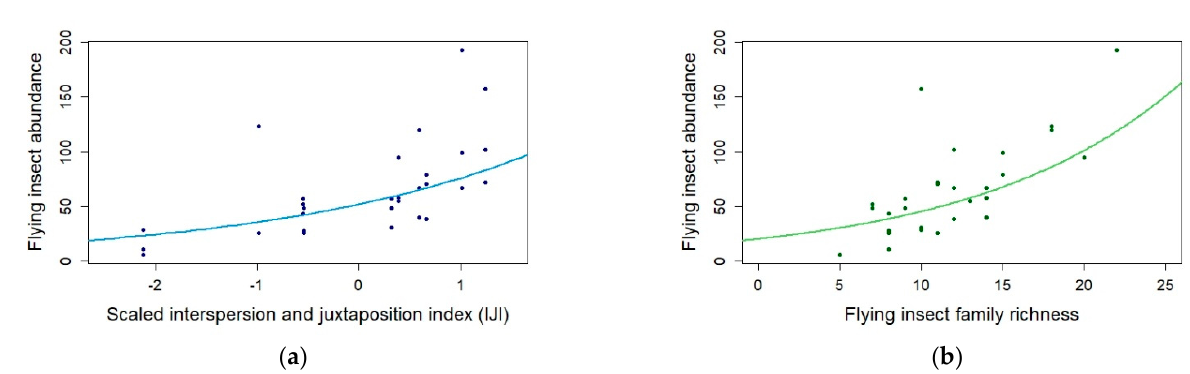
Figure 2. ( a ) Flying insect abundance variations according to the interspersion and juxtaposition index IJI (blue; E = 0.3747, p -value < 0.001); ( b ) Flying insect family richness (green; E = 0.0798, p -value <0.01) - Glmer with Poisson family; N = 30.